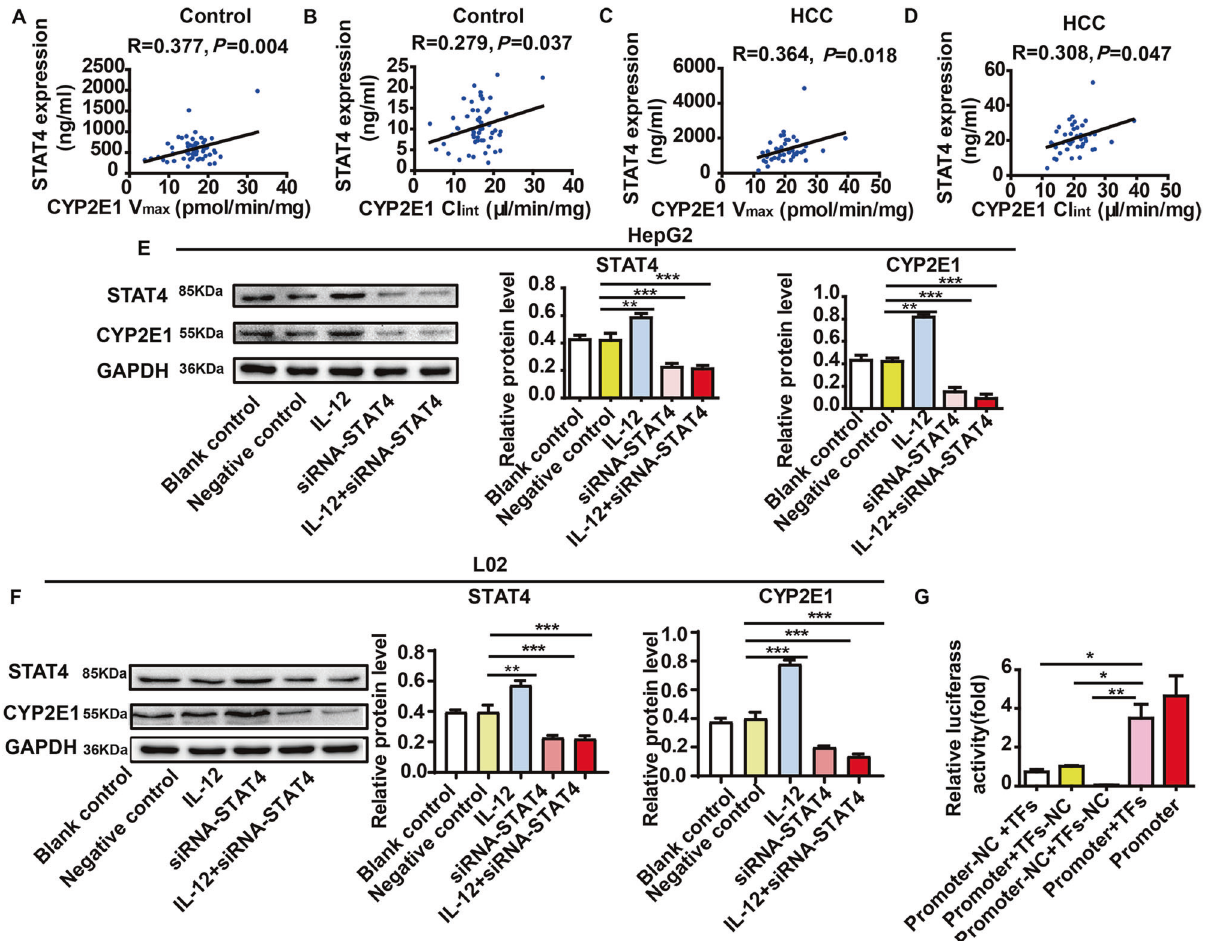
Fig. 4 The regulation by STAT4 of CYP2E1. A – D The correlation between content of STAT4 and activity of CYP2E1 ( V max and Cl int ) was analyzed. The result revealed that content of STAT4 was signi fi cantly positively correlated with the V max and Cl int in control and HCC liver tissues ( N = 42, R and P -values by Pearson ’ s correlation test are depicted). E , F The expression of STAT4 and CYP2E1 in HepG2 and L02 cells in the IL-12 treated group and the STAT4 siRNA group by western blot ( N = 3). GAPDH in each lane served as an internal control for normalization. HepG2 and L02 cells for 48 h with blank control group, negative control group, IL-12 group, and siRNA-STAT4 group. Data are representative of three independent experiments. G The effect of STAT4 on CYP2E1 promoter activity was detected by double luciferase reporter gene. Promoter-NC + TFs: STAT4 (TFs) and CYP2E1 promoter negative control plasmid; (CYP2E1 promoter + TFs-NC group): CYP2E1 promoter and STAT4-negative control plasmid (TFs-NC) group; CYP2E1 promoter-NC and TFs-NC plasmid group; CYP2E1 promoter and TFs (STAT4); Promoter: CYP2E1 promoter normal plasmid group ( N = 3). *P < 0.05, **P < 0.01, and ***P < 0.001 was assessed by one-way